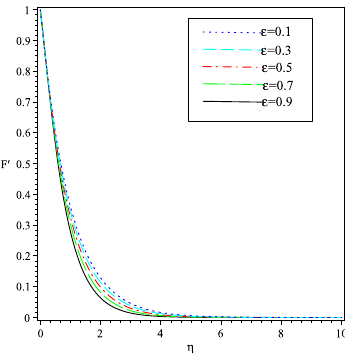
Fig. 13: Graph of (cid:107) Res (cid:107) 2 by indirect RBFs solution for ϕ = 0 , β = 0.4 and ε = 0.1 .